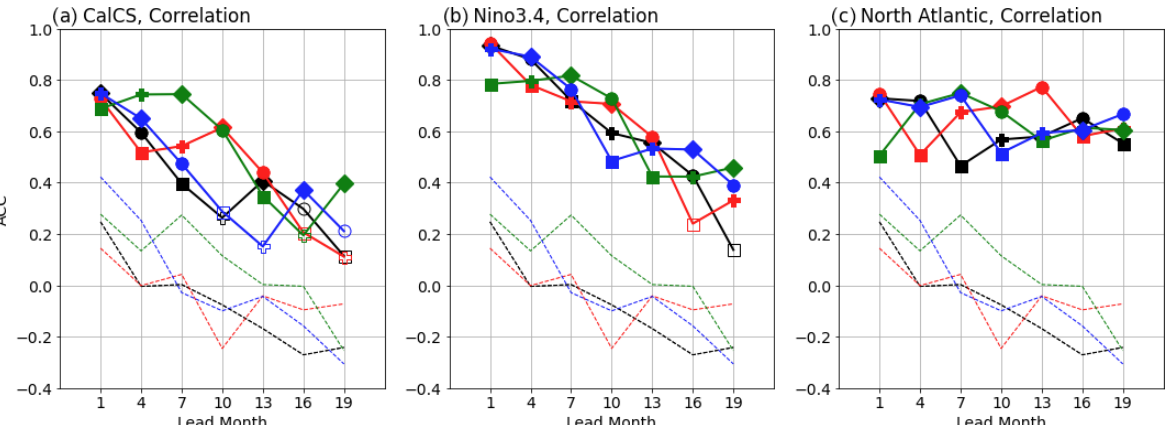
Figure 9. Anomaly correlation coefficients for aragonite saturation state ( (cid:127) arag) averaged over (a) the California Current System LME, (b) the Niño-3.4 region, and (c) the subpolar North Atlantic (55–60 ◦ N, 30–50 ◦ W). Colored solid lines and symbols denote SMYLE initial- ization month and verification season, respectively. Colored dashed lines give persistence forecast results for different initialization months. Filled symbols in panels (a) – (c) indicate significant ACC scores ( p <